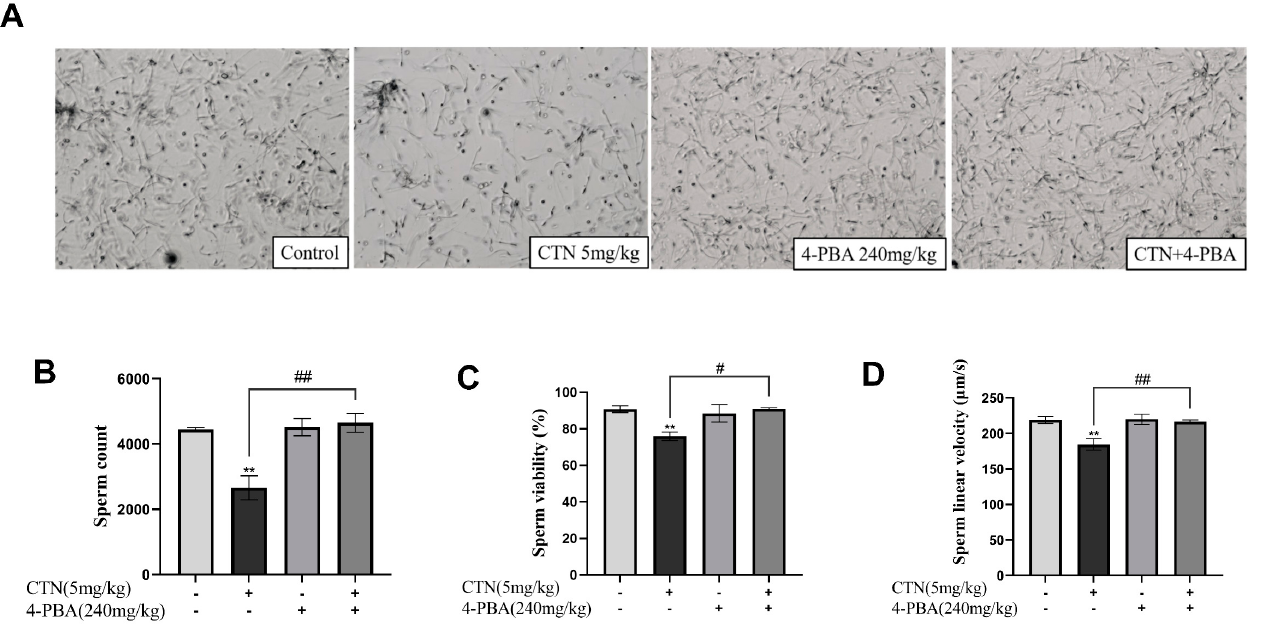
Figure 10. The effects of 4-PBA on CTN-induced spermatogenesis disorders in mice. ( A ) sperm count and morphology; ( B ) Sperm count; ( C ) Sperm viability; ( D ) Sperm linear velocity. The above data are expressed as SEM ± mean, ** p < 0.01, compared with the control group, # p < 0.05, ## p < 0.01, compared with the CTN